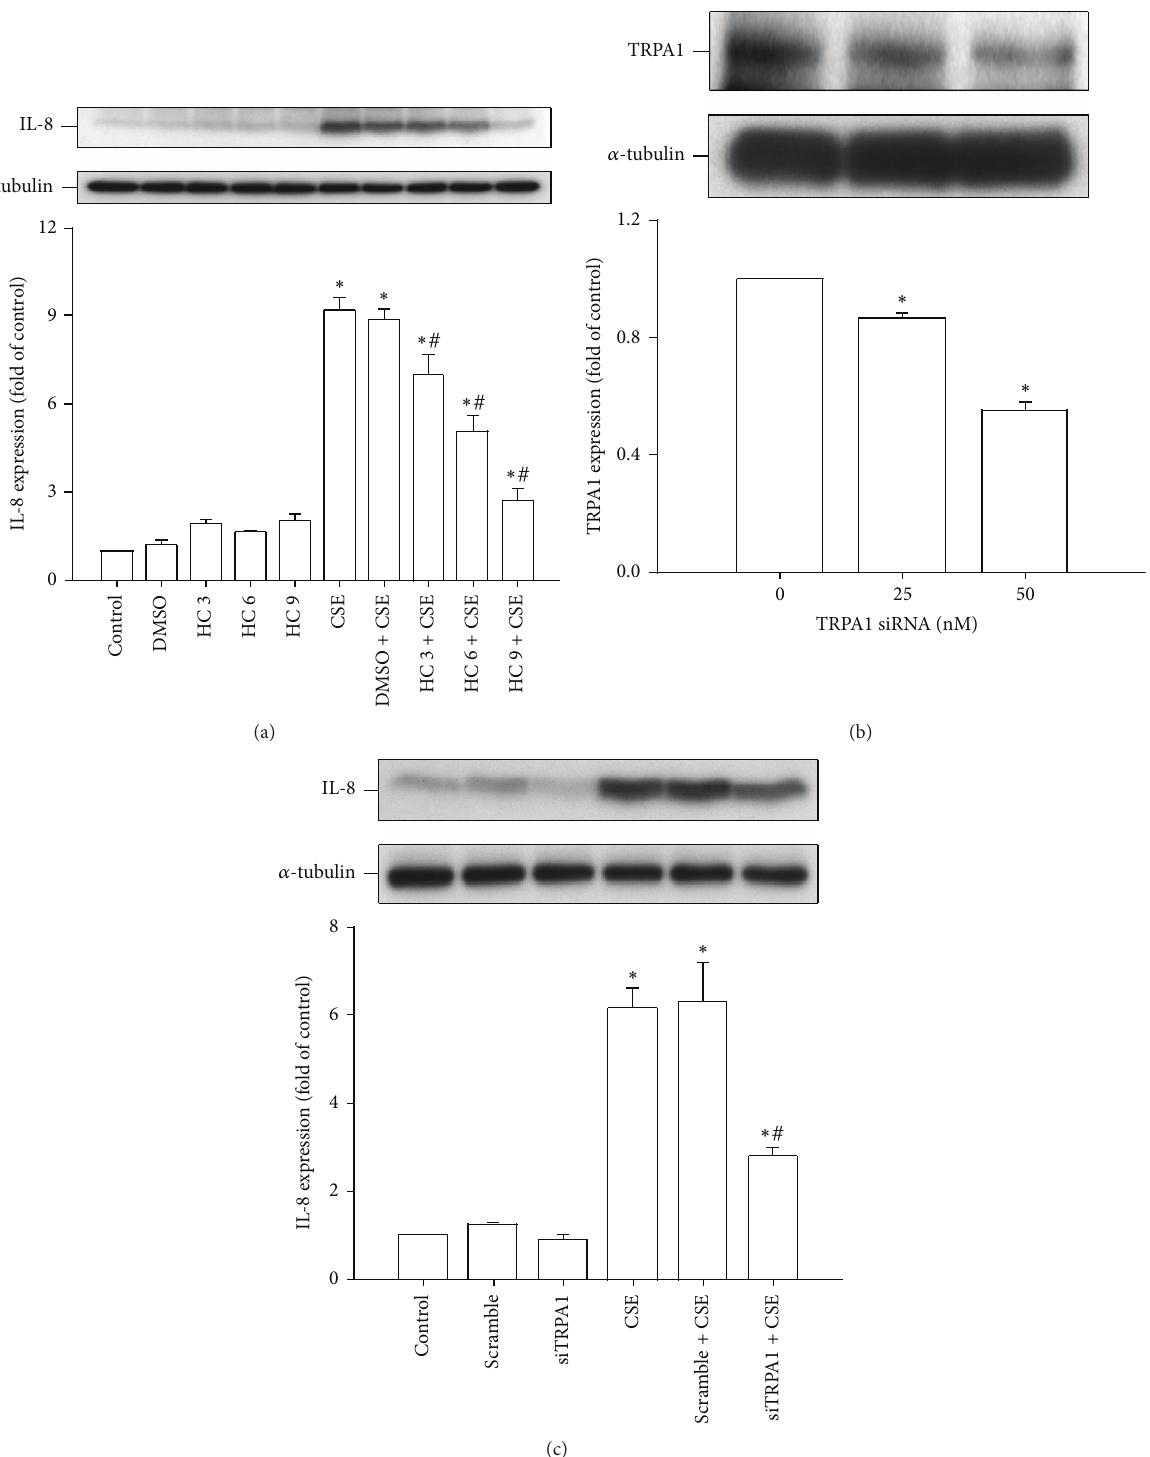
Figure 2: TRPA1 is important for the induction of IL-8 by CSE in HBECs. (a) Cells were incubated with medium alone or exposed to 3% CSE for 24 hours and pretreated with 3–9 𝜇 M HC-030031 (HC, a TRPA1 antagonist) or its vehicle DMSO. (b) Cells were incubated with or without two concentrations (25 and 50nM) of TRPA1 siRNA (siTRPA1) for 24 hours prior to the measurement of TRPA1 expression. (c) Cells were incubated with medium alone or exposed to 3% CSE for 24 hours having been pretreated with 50 nM of either siRNA (siTRPA1) or scramble siRNA. Data in each group are mean ± SEM from five independent experiments. ∗ 𝑝 < 0.05 versus the control or versus time zero; # 𝑝 < 0.05 versus CSE